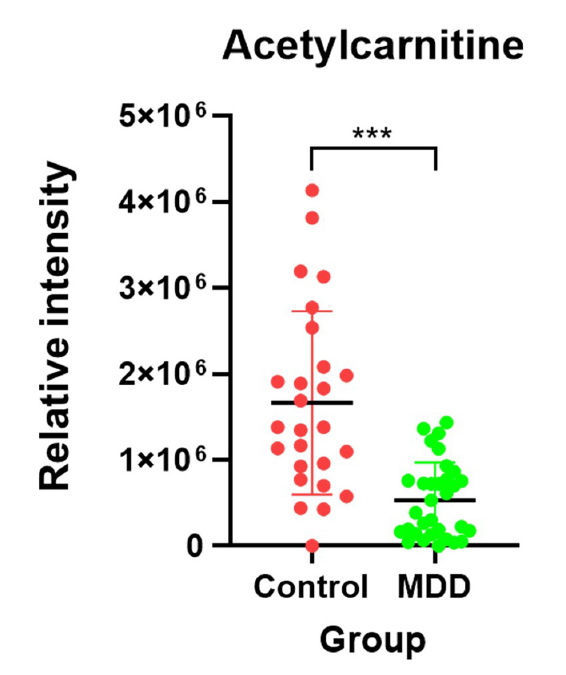
FIGURE4 Candidate biomarker for diagnosis of MDD. The red dot indicates the control group, and the green dot indicates the MDD group. After the Shapiro-Wilk normality test, a difference test was performed through the Mann-Whitney test. Each red and green vertical line represents the standard deviation, and the central black line represents the mean. The schematic and statistical work were performed using GraphPad Prism software (version 8.4.2). *** P <